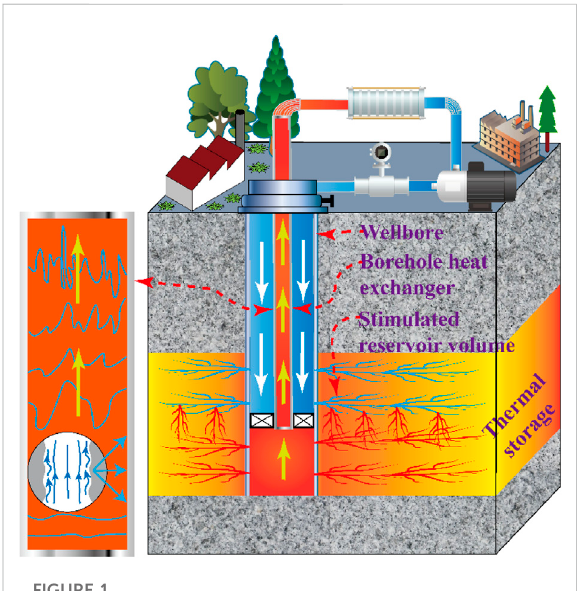
FIGURE 1 Schematic diagram of geothermal system